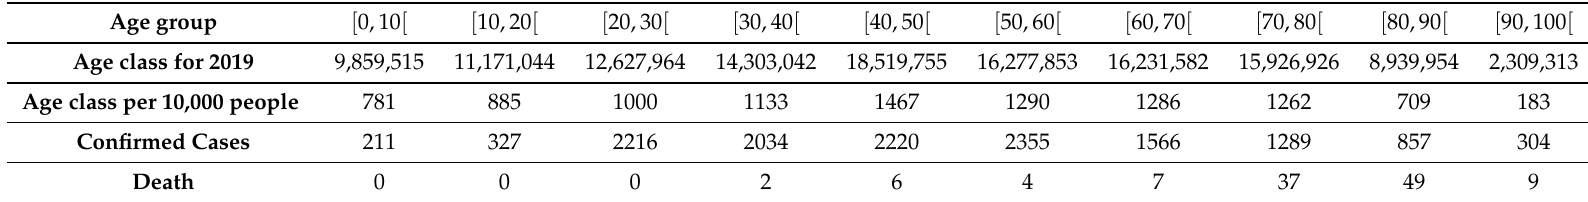
Table 1. The age distribution of Japan is taken from the Statistics Bureau of Japan [24]. The number of cases and the number of death the data come from Prefectural Governments and Japan Ministry of Health, Labour and Welfare.